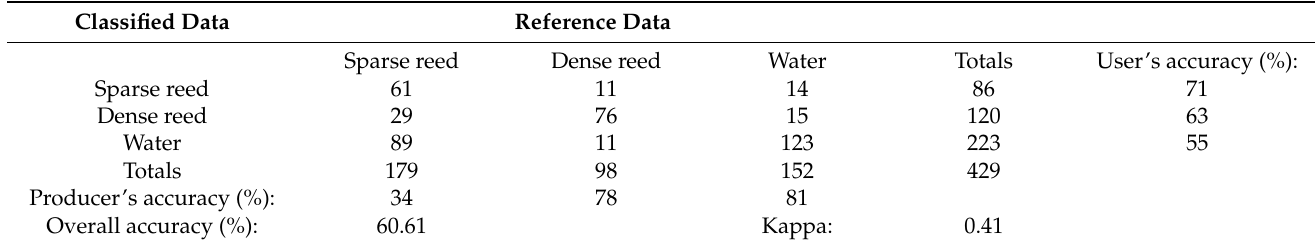
Table 3. Accuracy assessment showing the comparison between classified reed densities and reference data measured in the field.